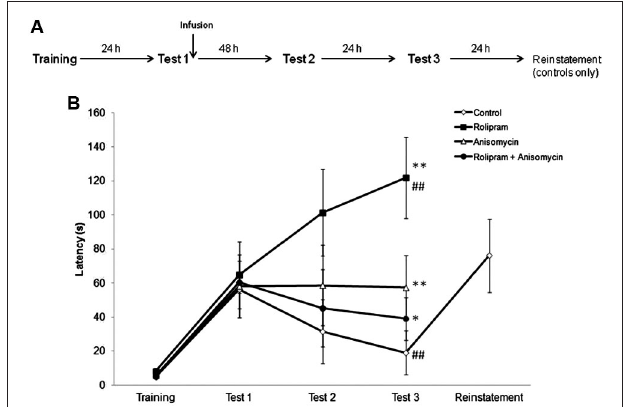
FIGURE 1 | The PDE4 inhibitor rolipram switches memory for IA from extinction to strengthening when given into the hippocampus immediately after retrieval . Rats were given an IA training trial followed 24 h later by a retrieval session (Test 1), which also served as an extinction training trial. Immediately after Test 1, animals were infused into the dorsal hippocampus with vehicle ( N = 9), rolipram (7.5 µ g/side, N = 10), anisomycin (80.0 µ g/side, N = 9), or rolipram combined with anisomycin ( N = 10). Retention test trials were carried out 48 (Test 2) and 72 h (Test 3) after Test 1. Vehicle-treated rats received a mild reminder footshock (0.2 mA) immediately upon stepping down on Test 3, and were given an additional test trial 24 h later (“Reinstatement”). (A) Schematic diagram showing the experimental design. (B) Rats given vehicle showed extinction of IA memory, whereas rolipram-treated rats showed memory strengthening, across test trials. The protein synthesis inhibitor